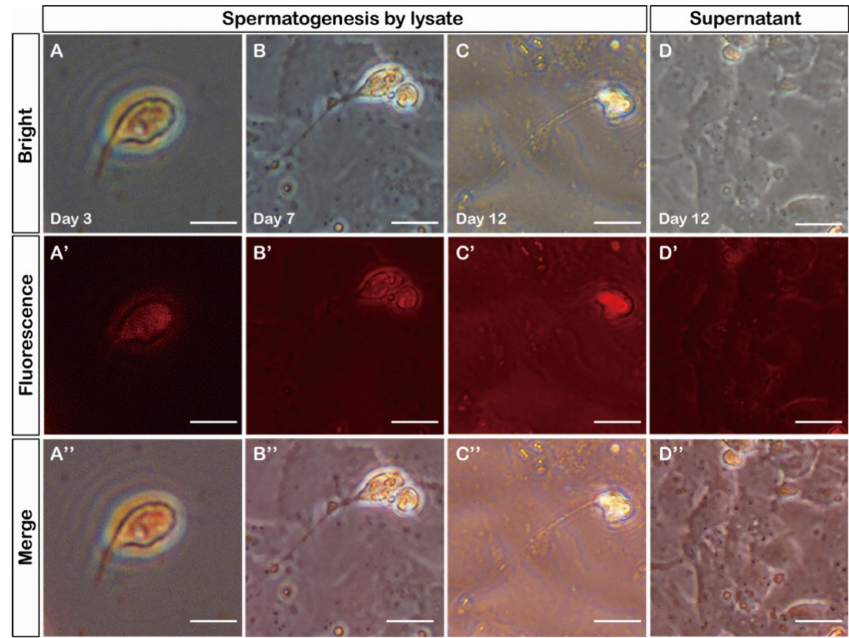
Figure 6. Induced differentiation in vitro . ( A – C ) SG3 cells were cultured with the lysate of CnGSC cells, and SG3 cells elongated to produce sperm cells. SG3 cells began to stretch out its tail at day 3; the head shrank and the tail pulled longer at day 12. ( D ) No sperm cells were observed after SG3 cells were cultured in supernatant for 12 days. (Bars = 10 µ m in ( A – D”